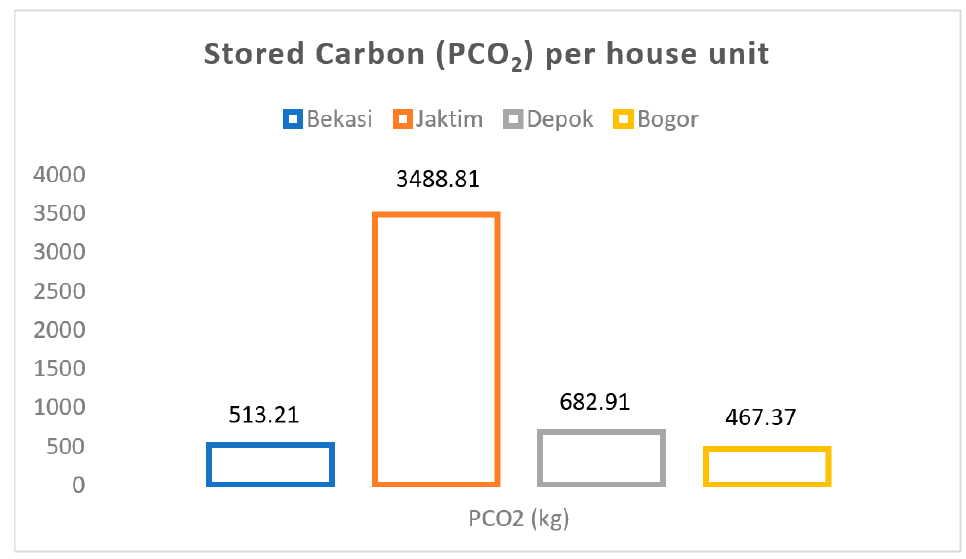
Figure 1. Total of stored carbon (PCO 2 , kg) in each house